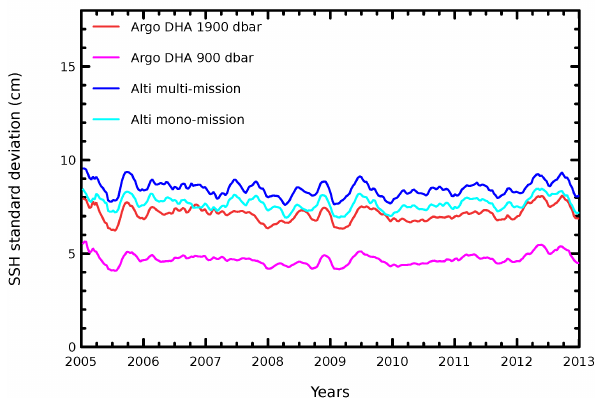
Figure 16. Time series of the DHAs derived from the profiles of float WMO 6901632 with different reference levels of integration varying from 900dbar (red), 1900dbar (blue), 3400dbar (green) down to 4000dbar (magenta) together with the collocated altime- ter SLAs